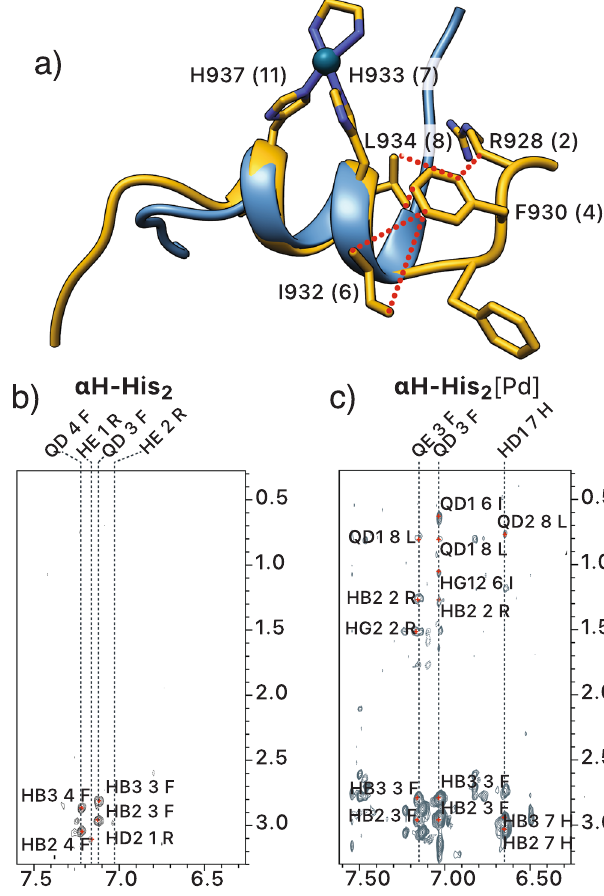
Fig. 3 NMR spectroscopy and computational studies con fi rm the nucleation of the α -helix in α H-His 2 [Pd]. a Experimental NMR conformation in solution (lowest energy) in yellow; NOEs are indicated as dotted lines superimposed with a representative conformation of the MD simulation (in blue). b , c Aromatic-side chain regions of the NOESY spectra. b native peptide. c in the presence of cis -PdCl 2 (en). Residues participating in NOEs are labeled. In the left panel only intra-residue NOEs are detected whereas in the right panel, both intra and inter residue NOEs are observed, indicating the presence of a helical conformation upon Pd binding. PDB structures available as Supplementary Data 1.